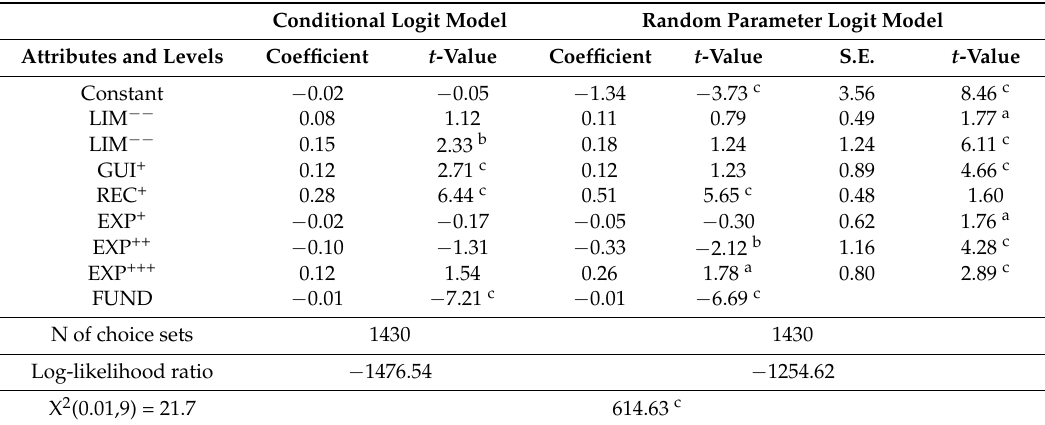
Table 3. Results of the conditional logit model and random parameter logit